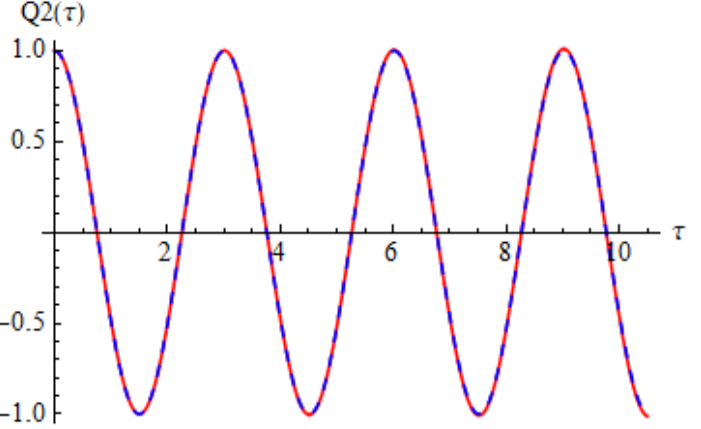
Figure 3. Comparison between the analytical solution (66) and numerical integration results for Equation (27): red solid line depicts numerical integration results while blue dashed line depicts analytical results.